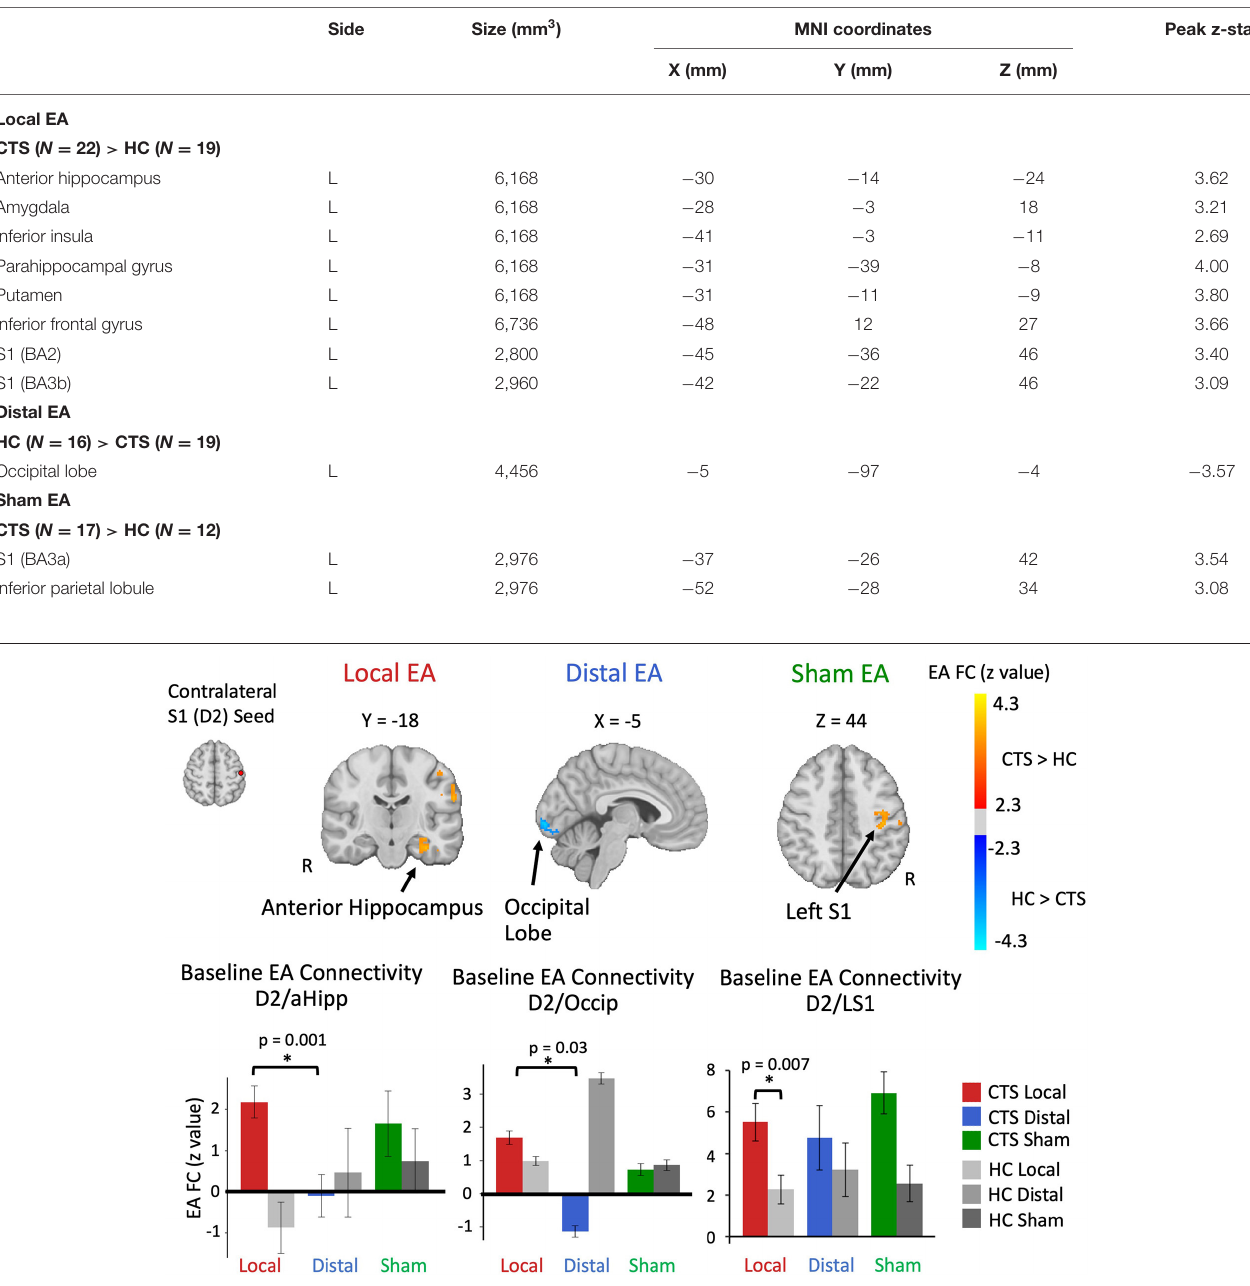
TABLE 2 | S1 (D2) functional connectivity for CTS patients vs. healthy controls during EA. Side Size (mm 3 ) MNI coordinates Peak z-stat